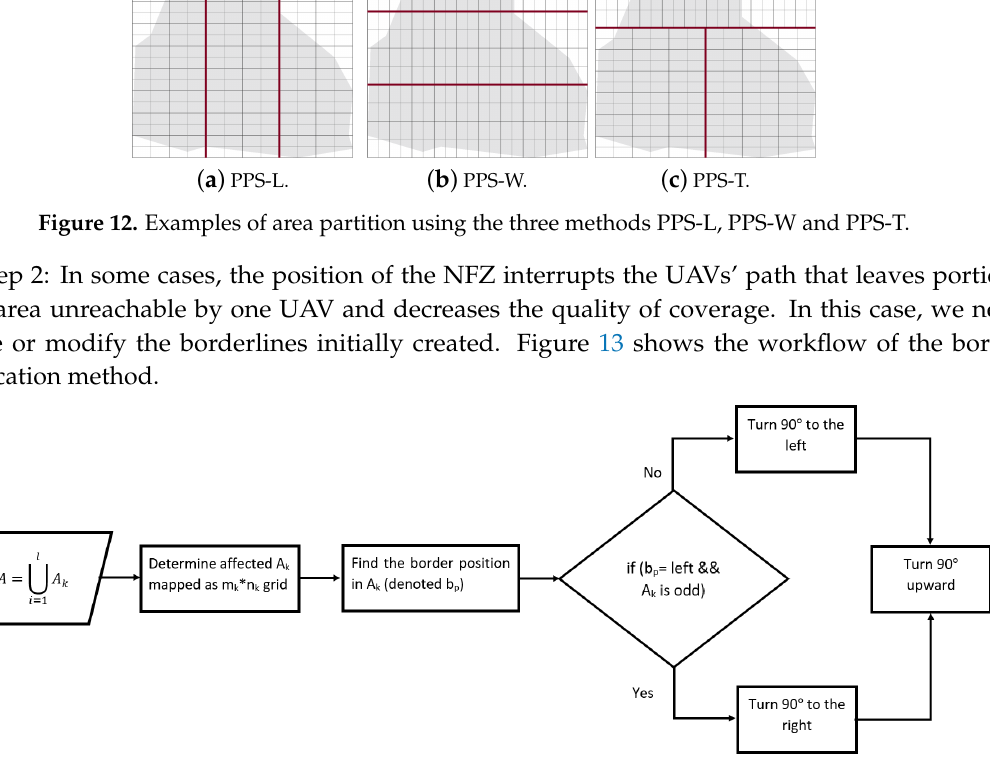
Figure 13. Modification border method